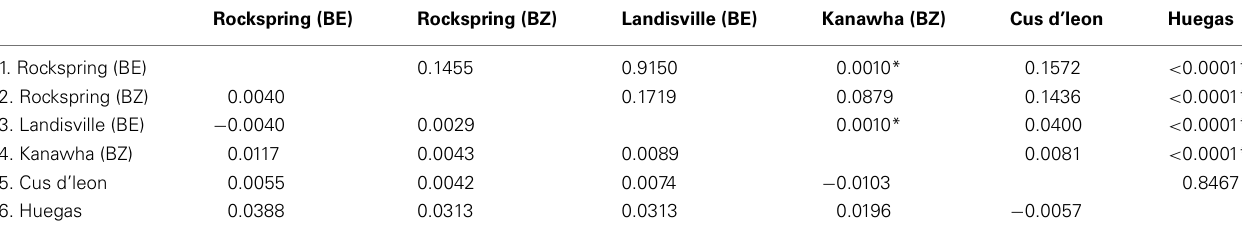
Table 2 | Ostrinia nubilalis population pairwise F ST estimates.